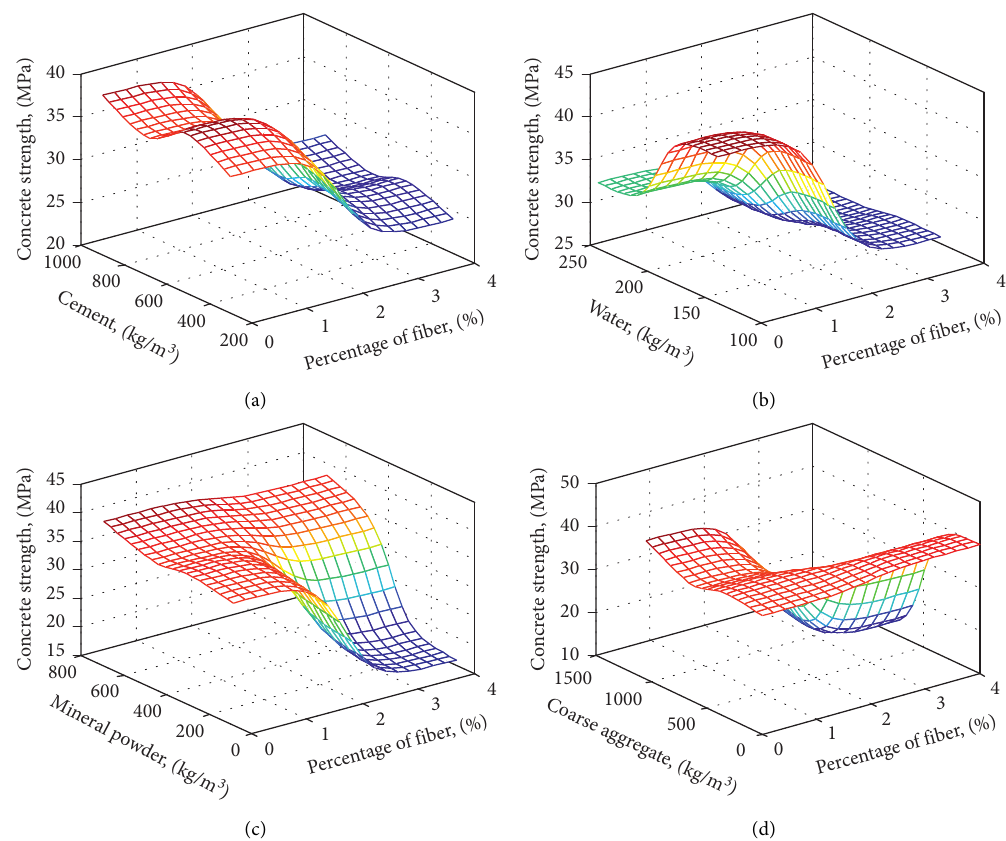
Figure 11: Relationship between different inputs and output. (a) VOF and CEM versus F28. (b) VOF and WTR versus F28. (c) VOF and MPR versus F28. (d) VOF and COA versus